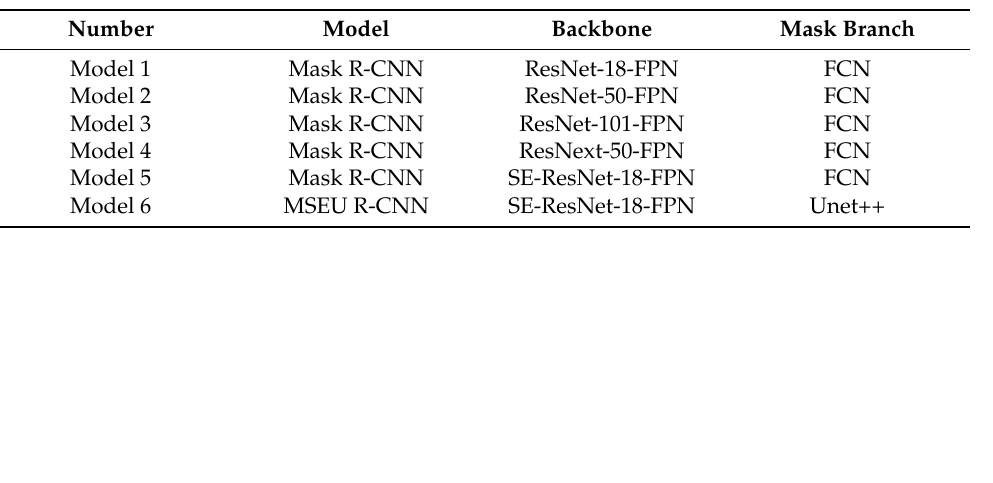
Table 5. Different model structures on citrus crown